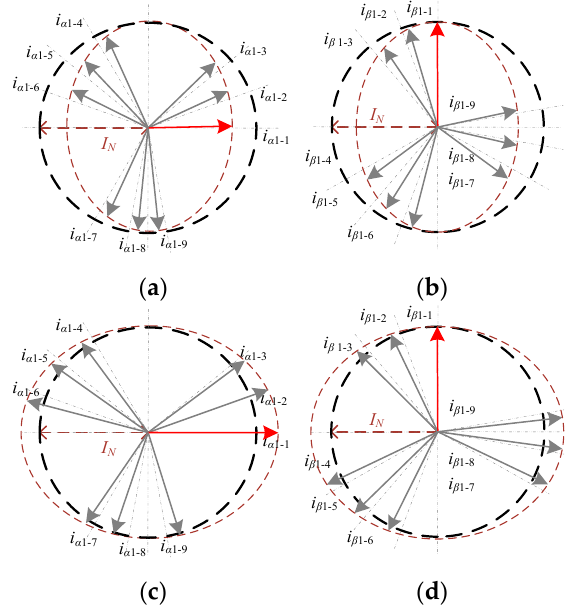
Figure 4. ( a ) i α 1_ N in loss signal fault; ( b ) i β 1_ N in loss signal fault; ( c ) i α 1_ N in gain fault; ( d ) i β 1_ N in gain